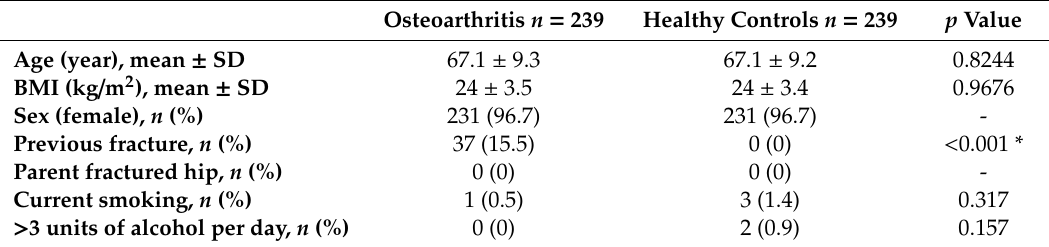
Table 3. Comparison of FRAX clinical risk factors between patients with knee osteoarthritis and healthy controls.